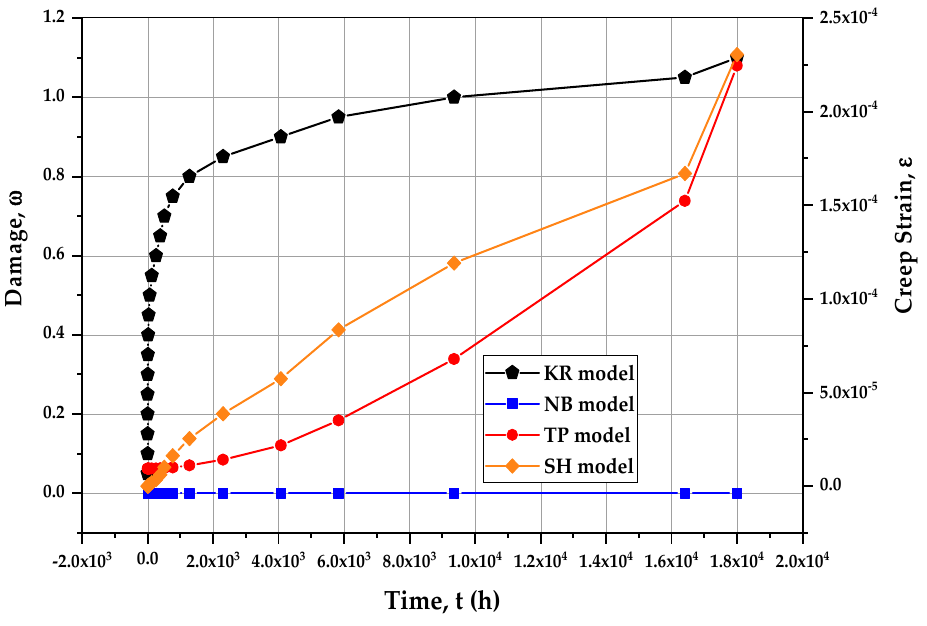
Figure 9. The stress rupture predictions of the models at 720 °C and 60 MPa.